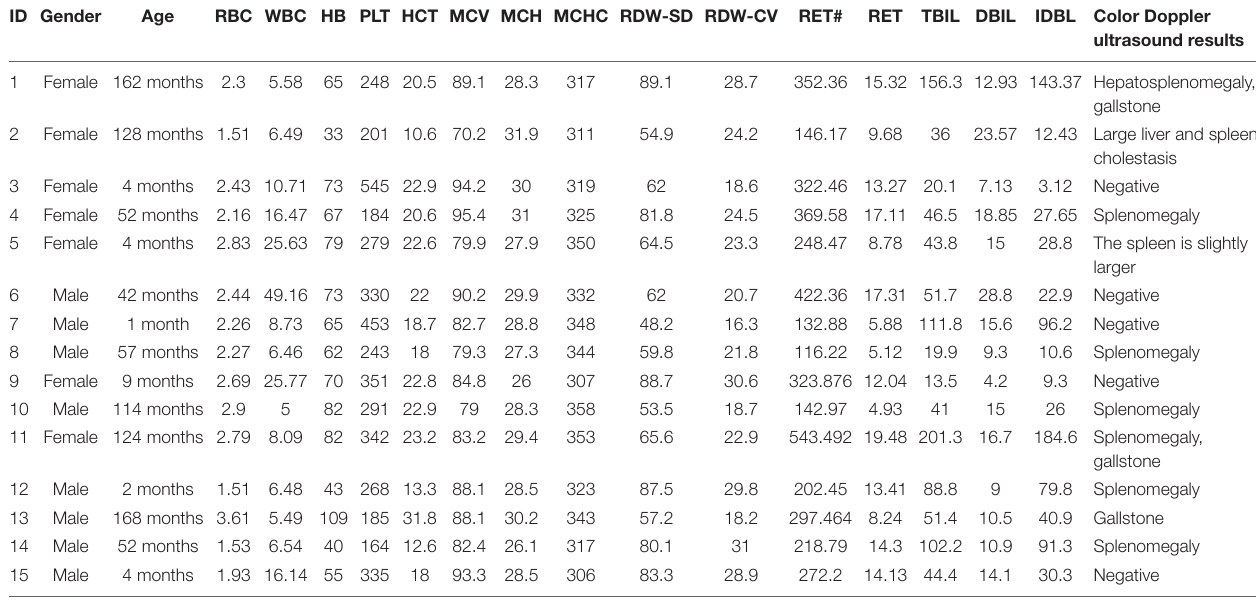
TABLE 1 | Clinical and laboratory features of these included hereditary spherocytosis patients. ID